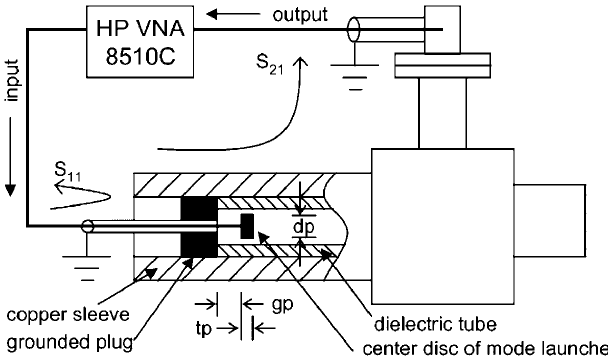
FIG. 7. Setup used for the rf benchtop measurement of the decelerator. A homemade mode launcher ( dp (cid:3) 3 : 24 mm , tp (cid:3) 2 mm , gp (cid:3) 4 : 67 mm ) couples power into the dielectric-loaded - TE coupler, and into a commer- waveguide, through the TM 01 10 cial waveguide-to-coax adapter.